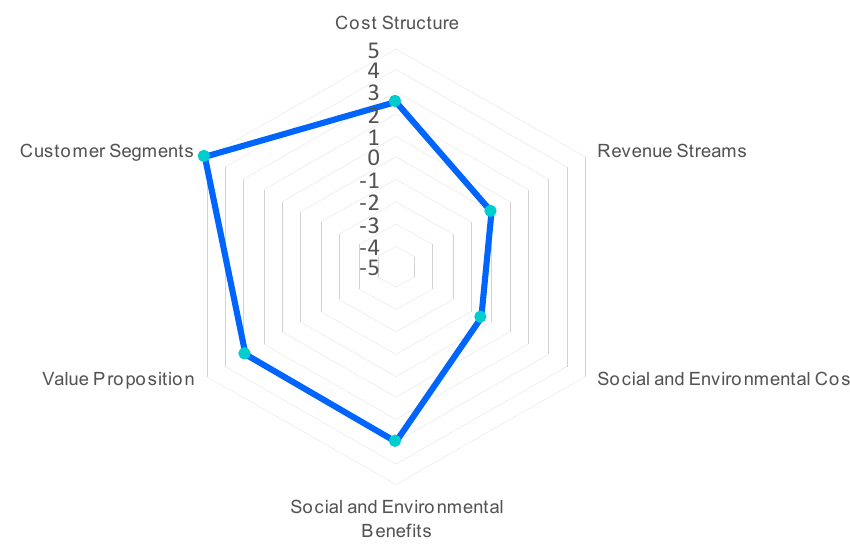
Figure 2. Radar chart of the Business Model Evaluation Tool of Santander’s Waste Management System.